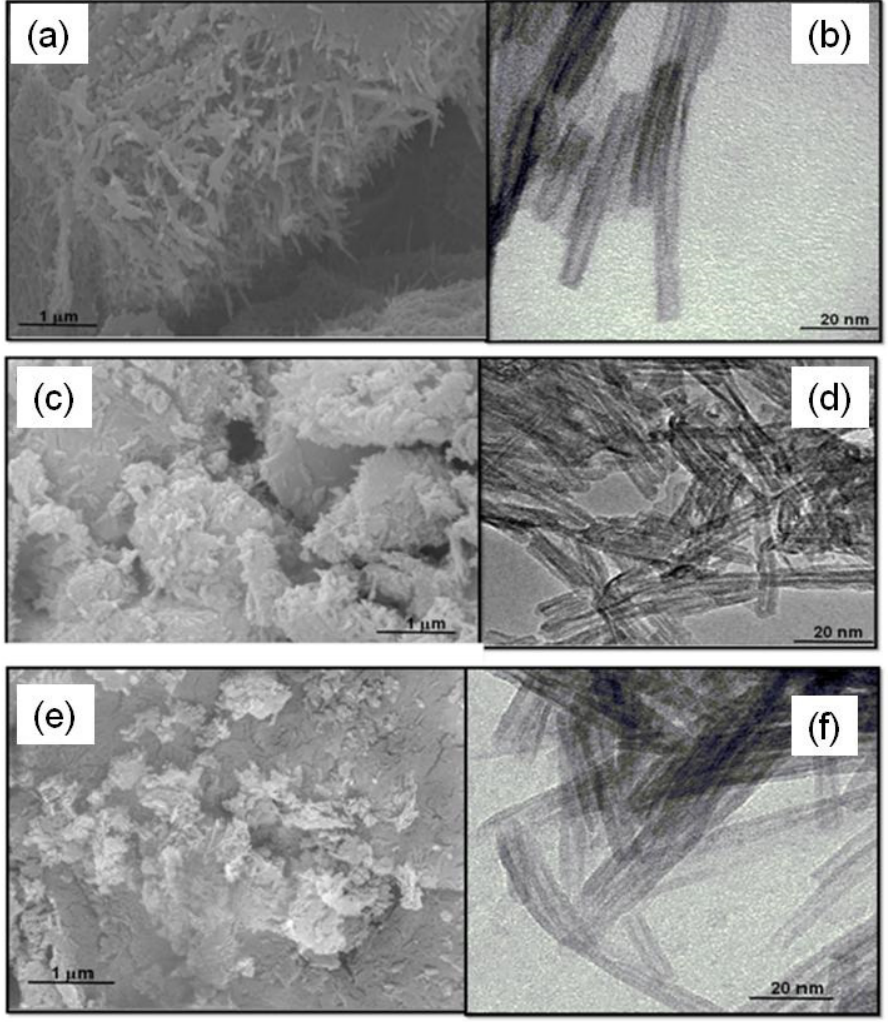
Figure 2. SEM-EDS and TEM micrographs of the catalysts studied: ( a , b ) NaNT, ( c , d ) CoNT, ( e , f ) CrNT.